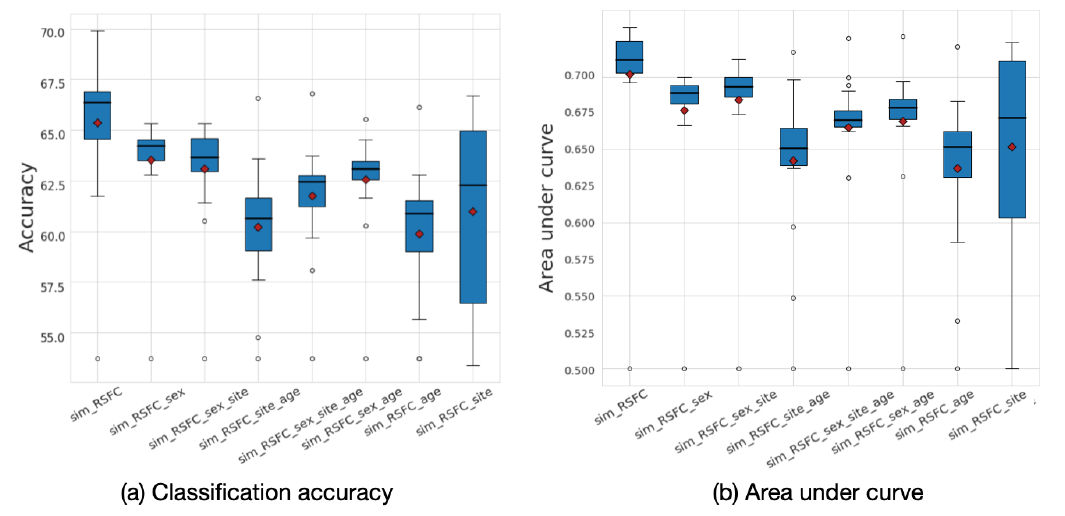
Figure 8. ( a ) Classification accuracy and ( b ) area under curve (AUC) results for each of the eight input graphs run separately for the ABIDE dataset. The mean values are shown as red